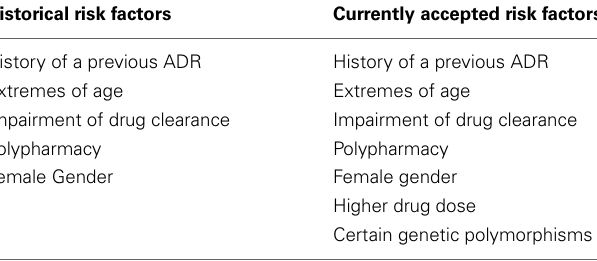
Table 1 | Risk factors for adverse drug reactions in children.